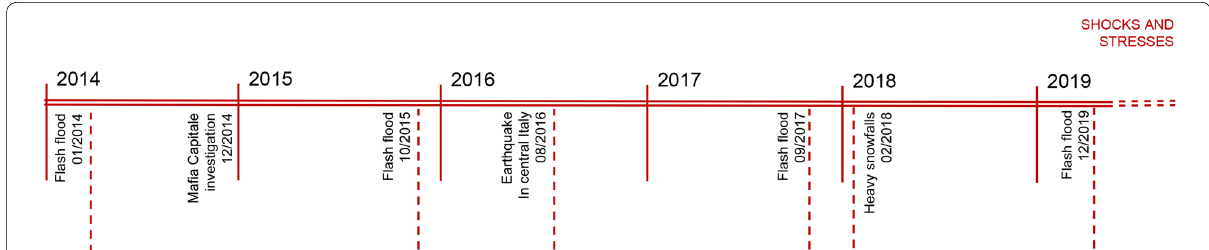
Fig. 1 Occurred shocks and stresses in Rome Source: Resilient Rome (2016)